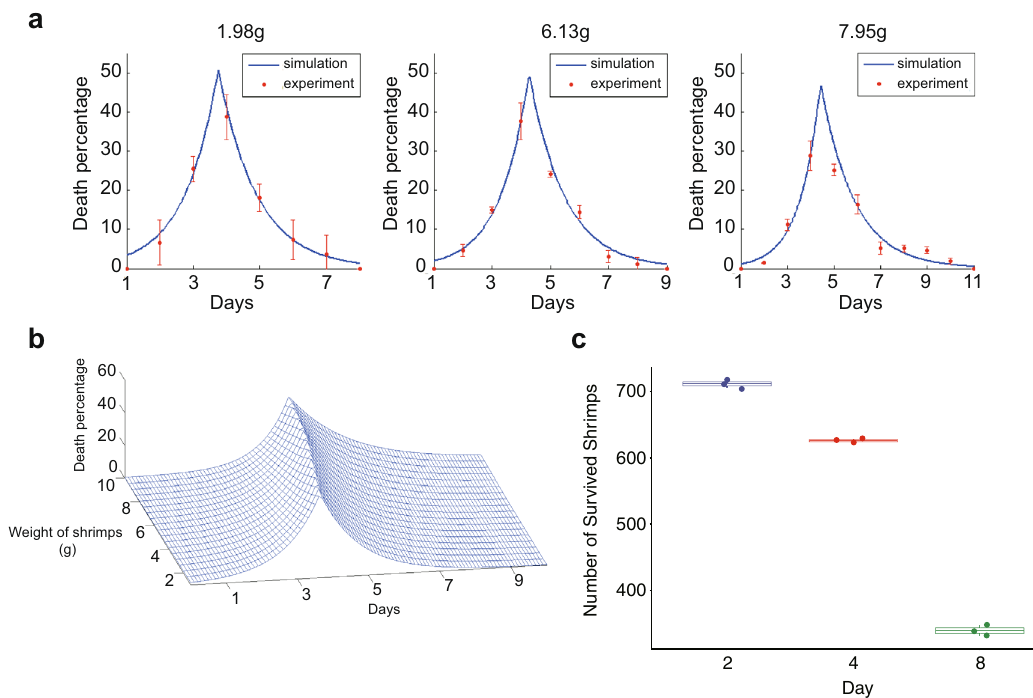
Fig. 1 Transmission dynamics of WSSV. a Daily death percentage of shrimp populations with initial WSSV-infected shrimp of different body weights. The red points with error bars are the results from experiments, and the solid blue lines are the results of model 1. b The illustration shows the death percentages of infected shrimp with different body weights each day. We estimate the parameters in model l and draw the above 3D surface to show the relationship between the death percentage concerning shrimp weights and time. For all shrimp weights, the death percentage rises at the beginning and then drops. The peak time for death was approximately the fourth day. c The relationship between the number of surviving shrimp and days after healthy shrimp were cocultured with WSSV-infected shrimp. Means and standard errors are shown ( n =